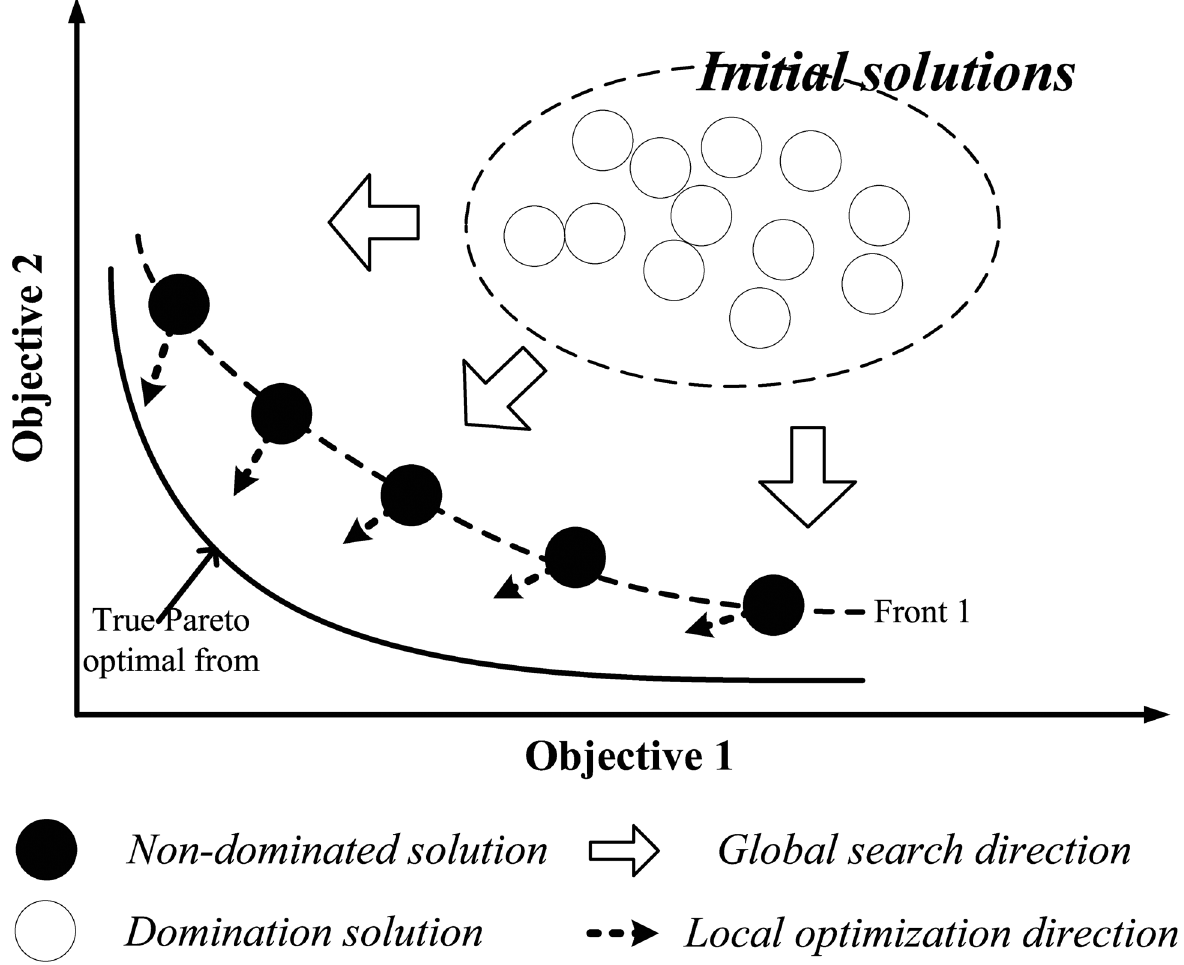
Fig 2. Sketch of multi-objective optimization